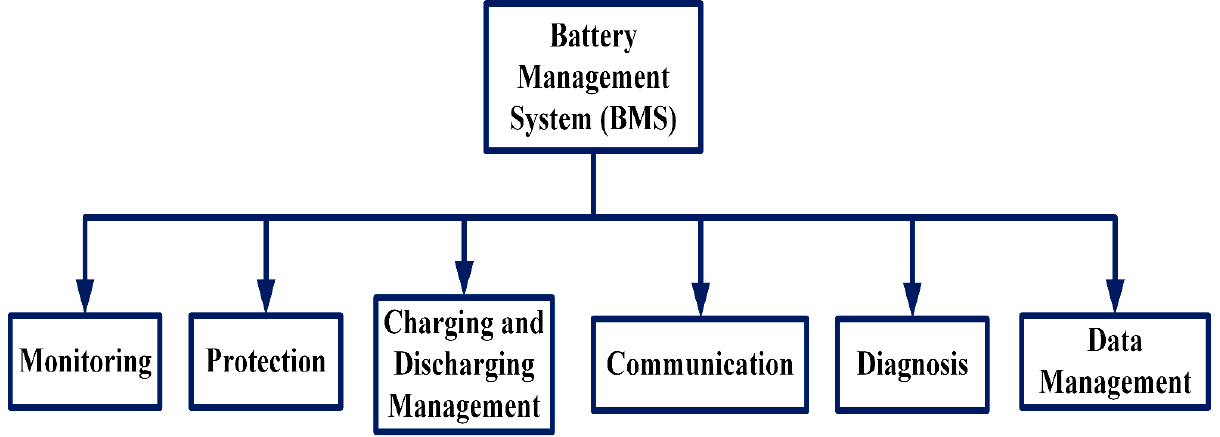
Figure 4. BMS functionalities.